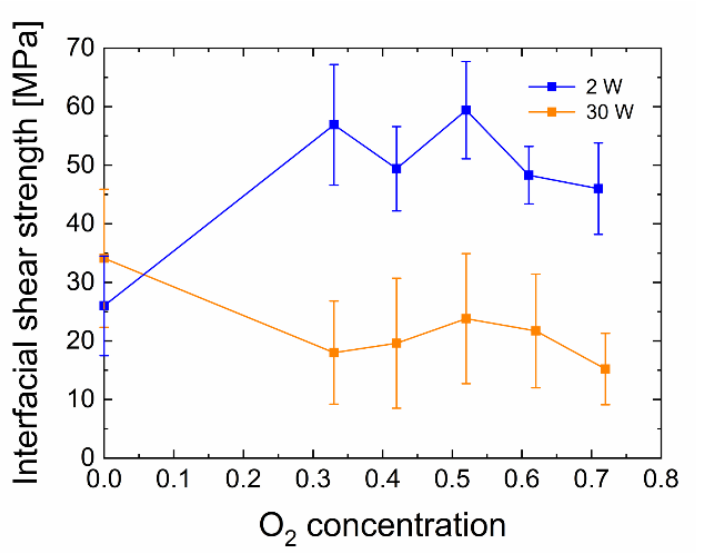
Figure 6. Influence of the oxygen concentration on interfacial shear strength (IFSS) values for two different powers.